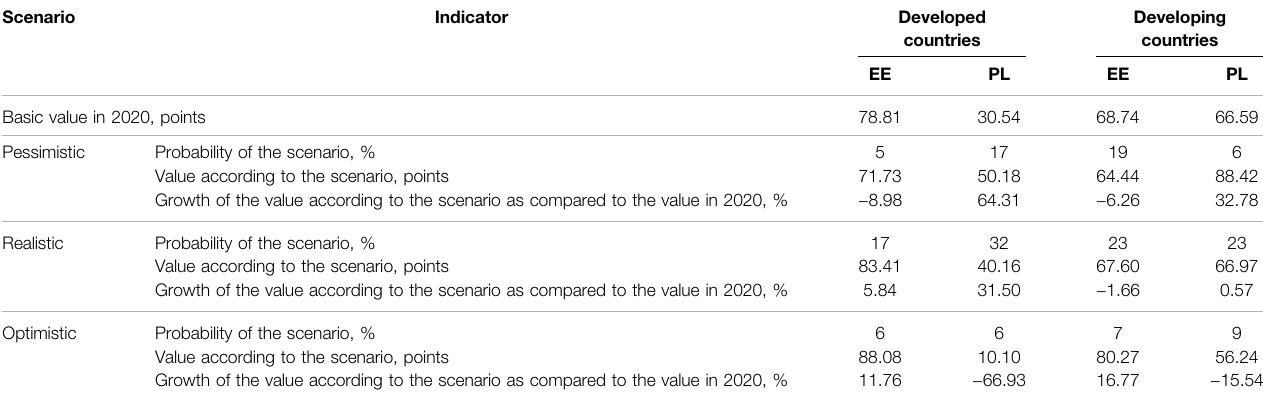
TABLE 2 | Scenarios of energy ef fi ciency and environmental pollution in developed and developing countries for the period until 2030.